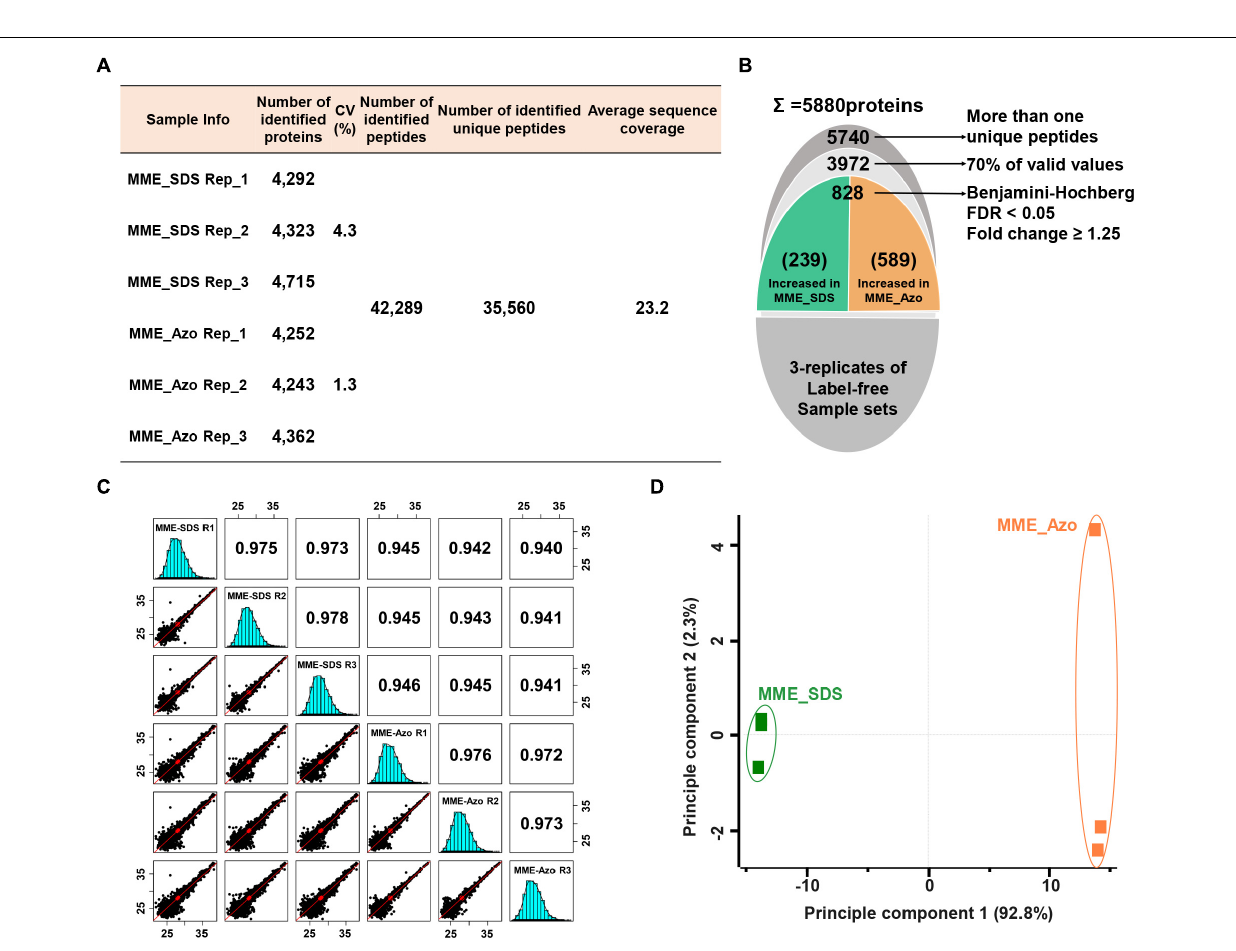
FIGURE 4 | Label-free quantitative proteomic analysis of microsomal membrane proteins solubilized in the SDS and Azo surfactants, respectively. (A) Table showing the information of identified proteins in two different sample sets with replicates. (B) The narrow-down approach for the identification of significantly modulated proteins. (C) Multi-scatter plots represent the Pearson’s correlation coefficient values of each sample solubilized in SDS and Azo. (D) Principal component analysis of significantly modulated proteins. MME_SDS, microsomal membrane extraction and dissolved in SDS buffer; MME_Azo, microsomal membrane extraction and dissolved in Azo